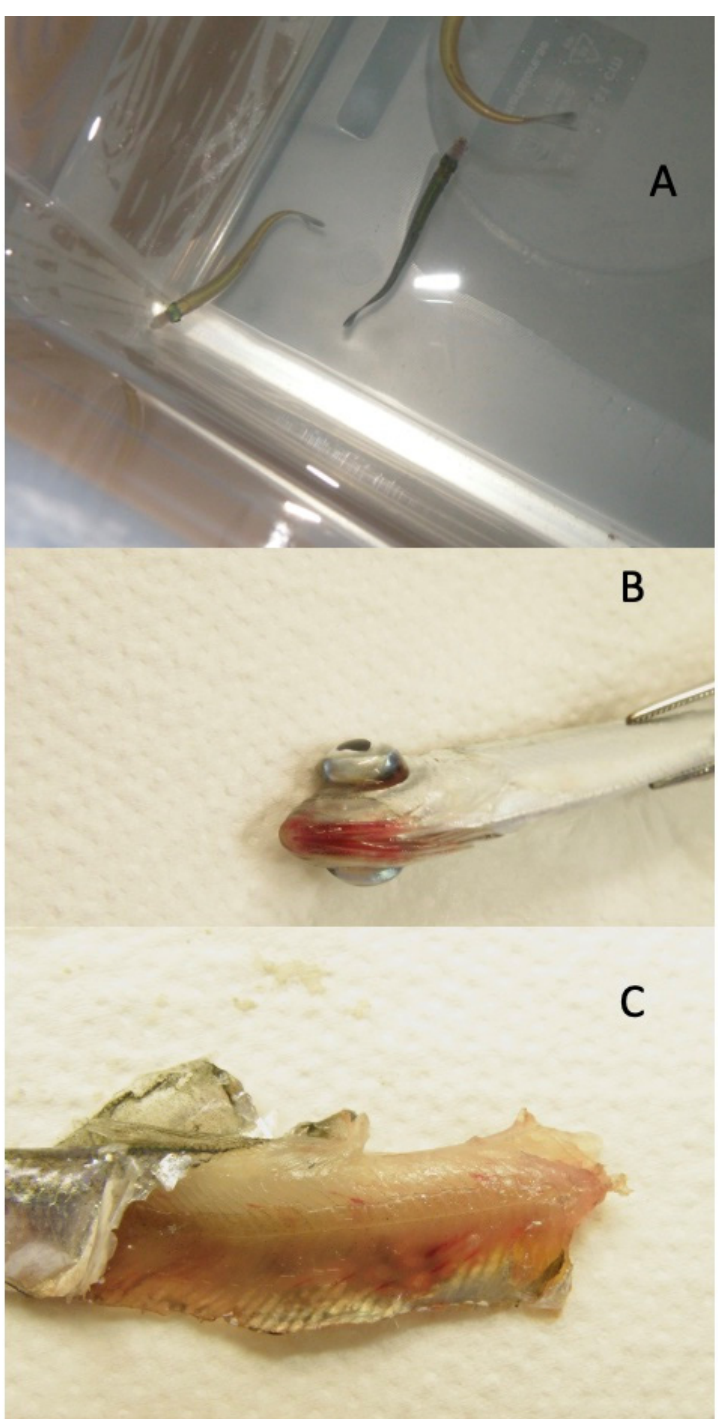
Figure 3. Gross pathology, Clupea harengus. Darkening of a single fish ( A ), often with a slight reddening of translucent parts of the head. Exophthalmia and hemorrhaging in the eyes, characteristic hemorrhages were observed in the eyes and around the mouth and gill covers ( B ). Hemorrhages in musculature ( C ).